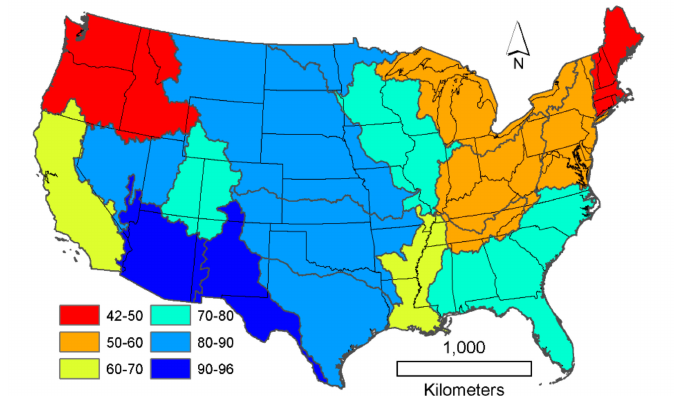
Figure 4. Spatial distribution of the ratio (%) of mean annual (1979–2015) HUC2-derived water-balance ET ( = P − Q ) and PRISM